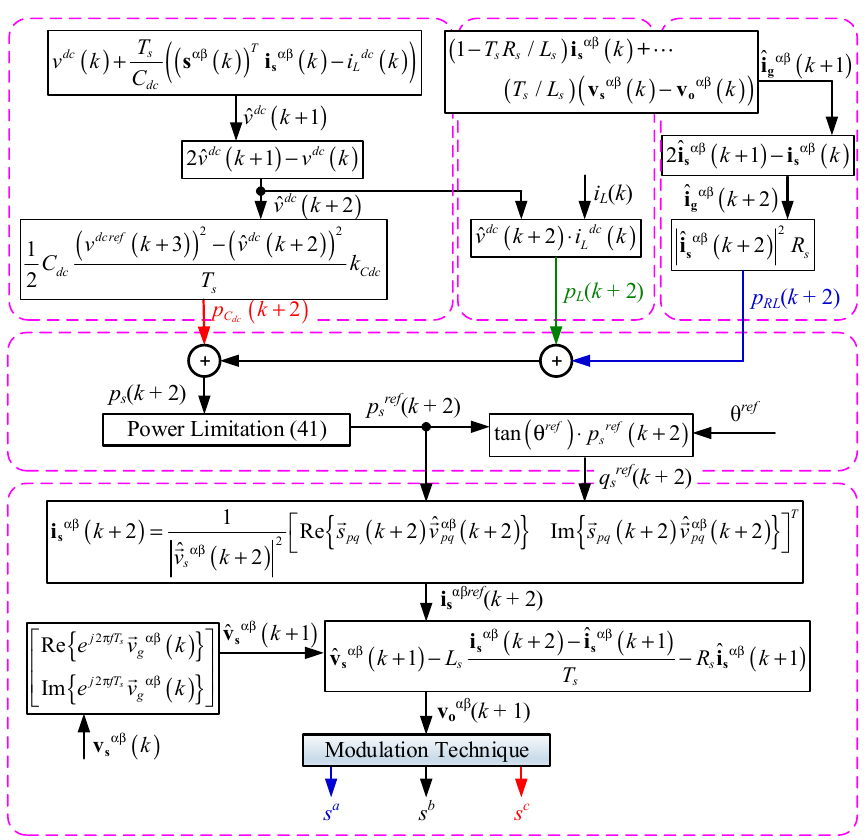
Figure 2. Converter control algorithm.